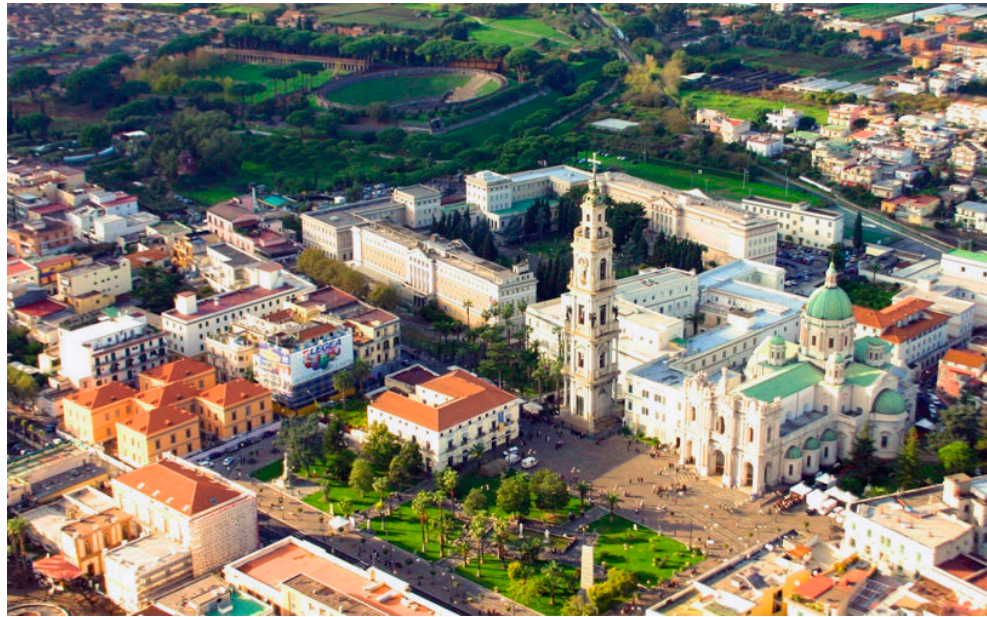
Figure 1. Pompei, Bartolo Longo Square. The Pontifical Shrine of the Blessed Virgin of the Rosary and its bell-tower are in the north side of the study area. Archaeological excavations and Roman amphitheatre are in the background.